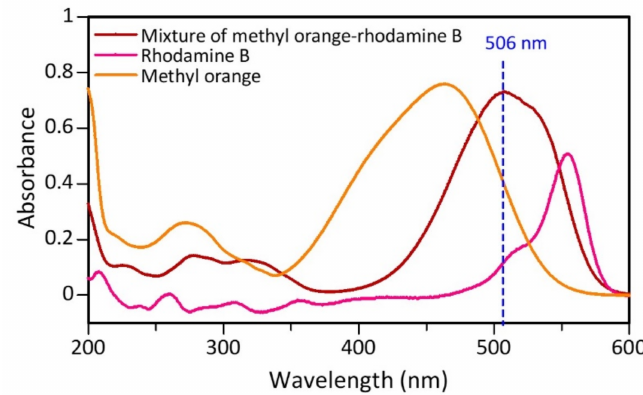
Figure 8. Maximum wavelength determination curve before the catalytic process for the dyes methyl orange, rhodamine B, and mixture (methyl orange-rhodamine B).